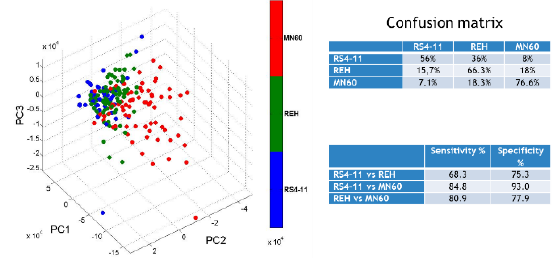
Fig. 1. 3D PCA scatter plots of the first three principal components for datasets obtained by analysing the characteristic vectors and the corresponding confusion matrix. Sensitivity and specificity are reported, too.